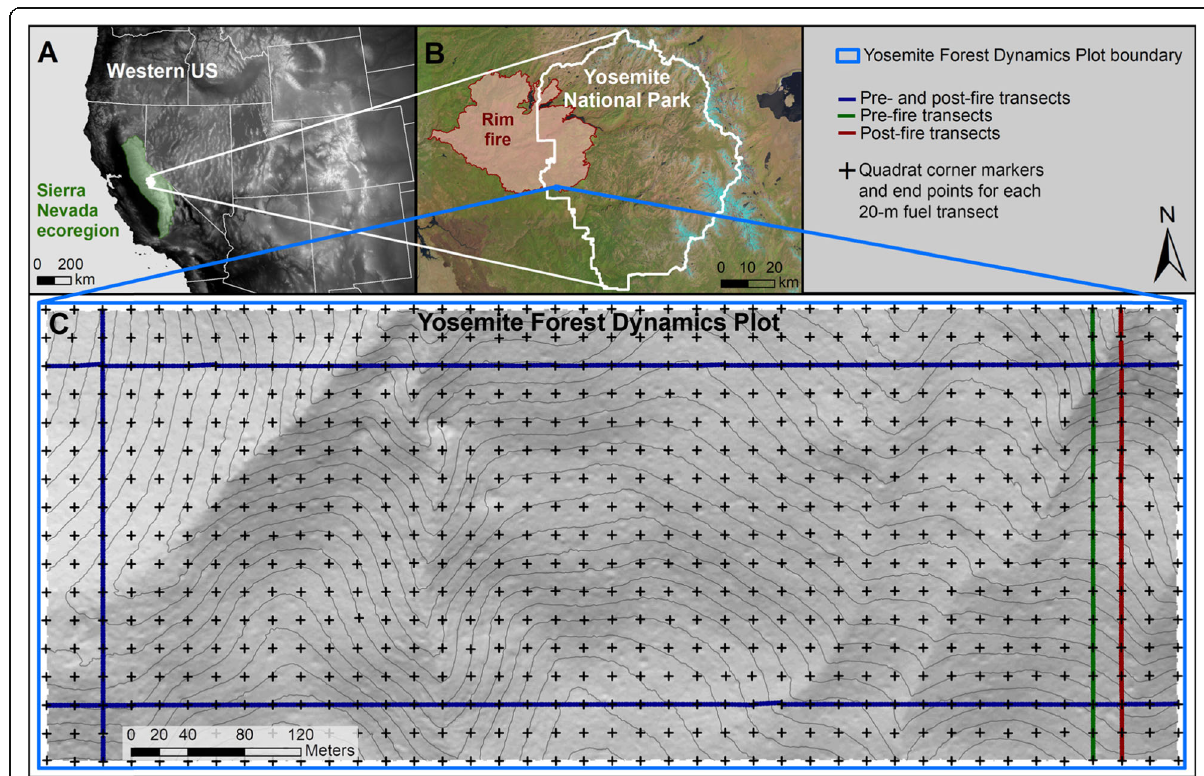
Fig. 1 The Yosemite Forest Dynamics Plot (YFDP) is located within the central Sierra Nevada ( a ), within the western portion of Yosemite National Park at the eastern extent of the area burned by the 2013 Rim Fire ( b ). The YFDP comprised 25.6 ha (800 m × 320 m) surveyed as 640, 20 m × 20 m quadrats ( c ). Explicit deadwood mapping of wood from the boles of trees ≥ 10 cm diameter and the location of wood from trees 1 cm ≤ diameter < 10 cm was performed within the entire YFDP. Surface fuels in standard classes (litter, duff, 1-h, 10-h, 100-h, and CWD; see the “ Methods ” section) were measured along planar transects ( “ Brown ’ s Transects ” ) in 2011 and 2014 – 2019. The shaded base layer is a digital elevation model derived from 1-m resolution lidar. The eastern-most pre-fire transect (2011) was located 20 m west of the permanent transect points used for post-fire (2014 – 2019) measurements ( c ). Figure derived from Cansler et al. 2019; their Fig.